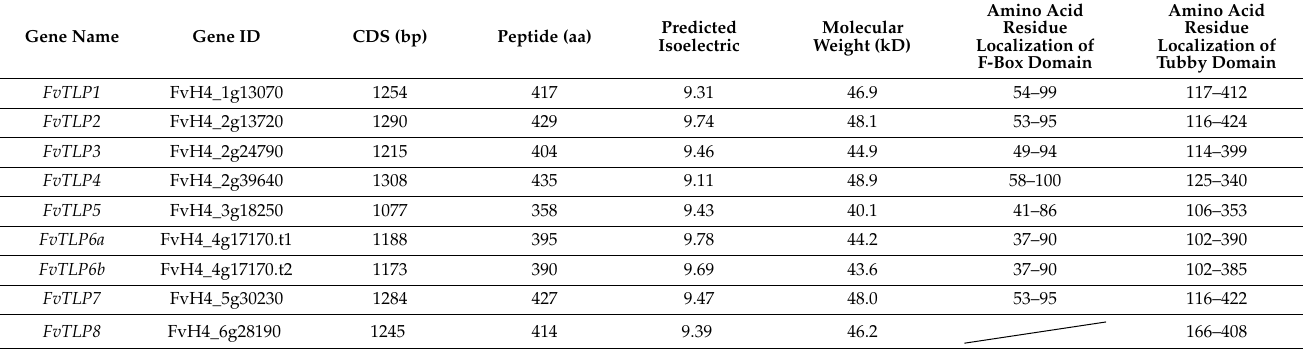
Table 1. Identification and characteristics of TLP genes in Fragaria vesca